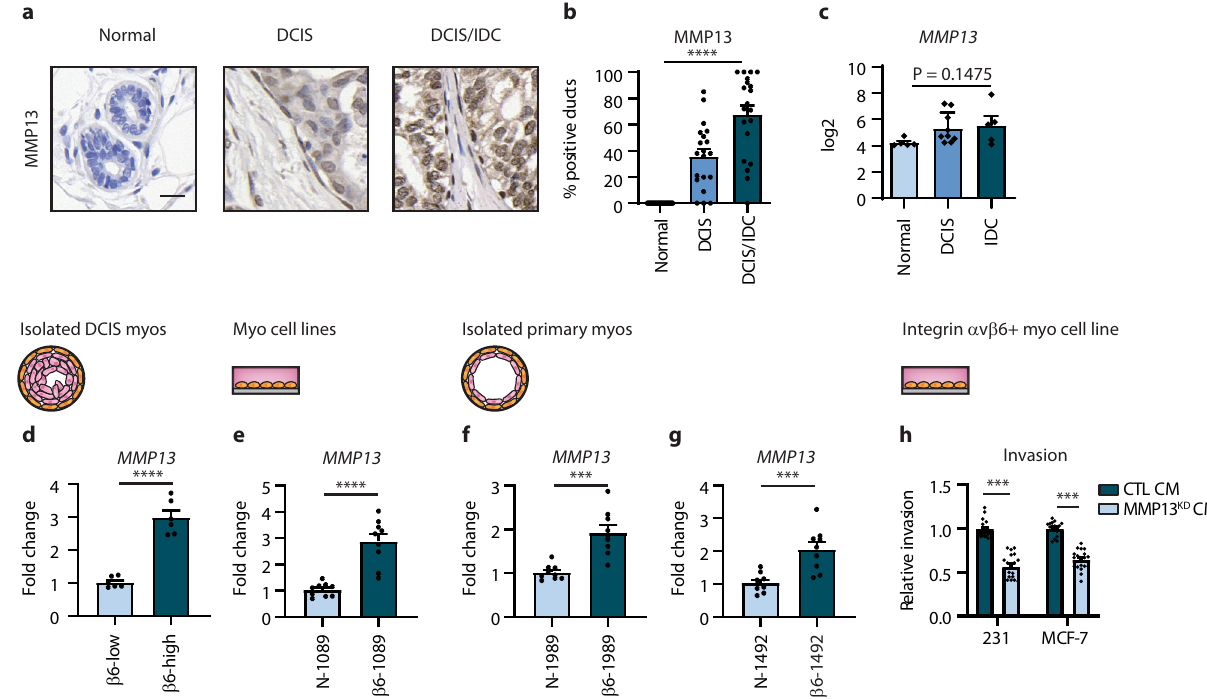
Fig. 4 MMP13 expression correlates with human DCIS progression to invasion and promotes breast cancer cell invasion in vitro. a Representative images of MMP13 by immunohistochemical staining in human breast tissue samples featuring adjacent normal ducts, DCIS and DCIS/IDC. Scale bar, 20 μ m. b Bar graphs showing the mean and individual percentage of ducts positive for MMP13 in adjacent normal ( n = 40), DCIS ( n = 20) and DCIS/IDC ( n = 20) patient samples (error bars, + s.e.m). **** P < 0.0001 (Kruskal – Wallis one-way ANOVA). c mRNA expression of MMP13 in normal breast tissues ( n = 5), DCIS ( n = 9) and IDC ( n = 5) (error bars, + s.e.m). * P = 0.0373 (Kruskal – Wallis one-way ANOVA). d – g Bar graphs showing qRT-PCR analysis for MMP13 using RNA isolated from DCIS myoepithelial cells with integrin β 6-low and β 6- high expression ( d ), myoepithelial cell lines; N-1089 and β 6-1089 ( e ) and from primary normal myoepithelial cells; 1989 ( f ) and 1492 ( g ) transfected with an empty vector (N-) or integrin β 6 expression construct ( β 6-) (error bars, + s.e.m). n = 3 biological replicates, 3 technical replicates; **** P < 0.0001 (d,e), *** P = 0.0001 ( f ) and *** P = 0.0006 ( g ) (two-tailed t -test). h Invasion assay for MDA-MB-231 (231) and MCF-7 cells using conditioned media (CM) isolated from myoepithelial cell line; β 6-1089 transfected with a control (CTL) or MMP13-targeted (MMP13 KD ) siRNA (error bars, + s.e.m). n = 3 biological replicates, 4-6 technical replicates; *** P = 0.0001 (two-tailed t